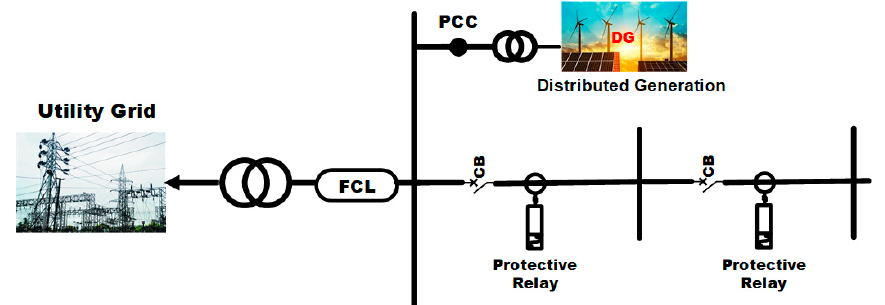
Figure 10. Fault current limiter–DG system interconnection.